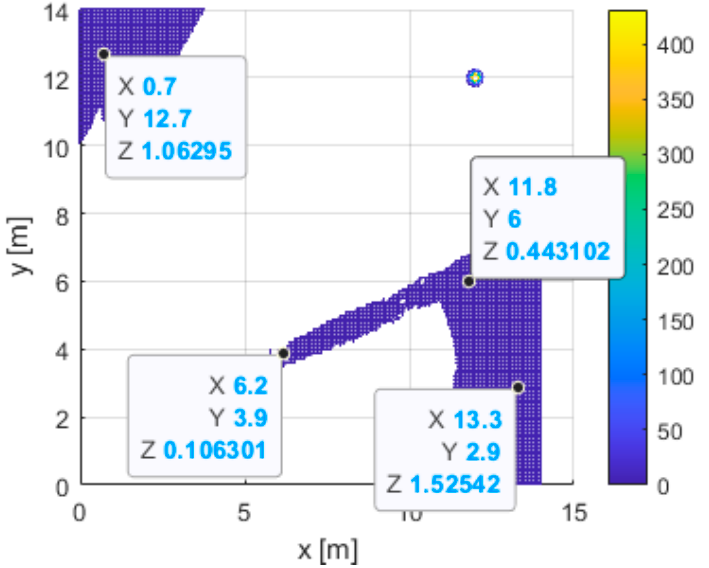
Figure 19. Data of the values outside the desired range obtained through the Lyapunov incremental function ∆𝐿 for Agent J.